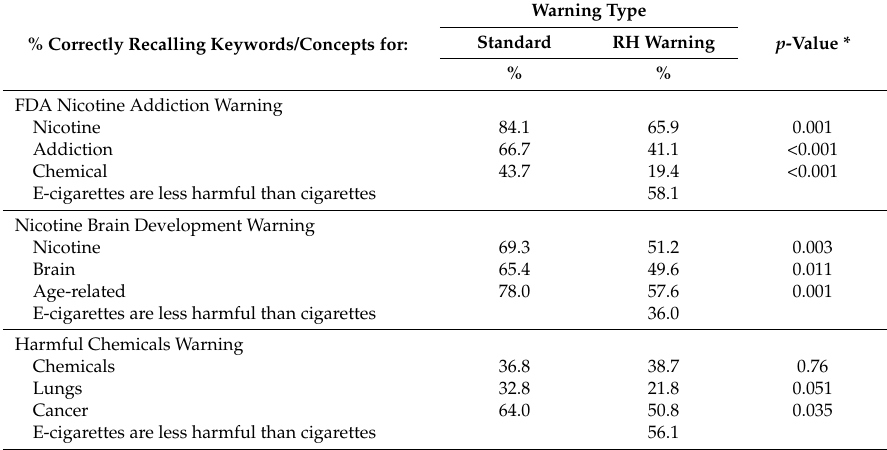
Table 3. Unaided recall of warning keywords and concepts by warning theme and